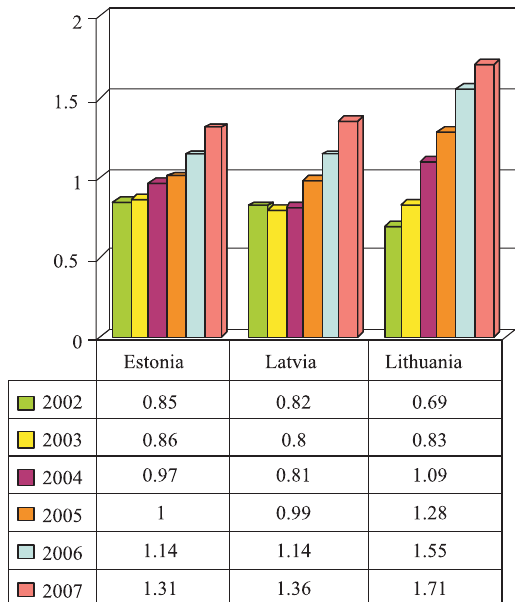
Fig. 4. Th e dynamics of the export of transport services in the Baltic States, bill. EUR